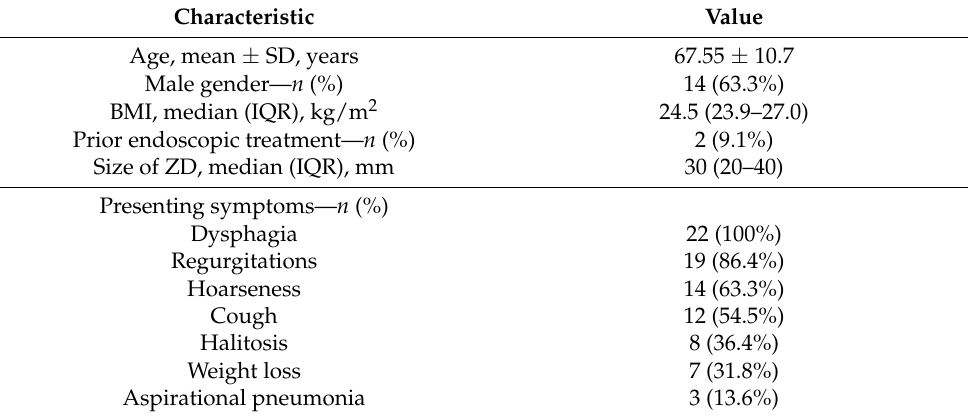
Table 2. Patients’